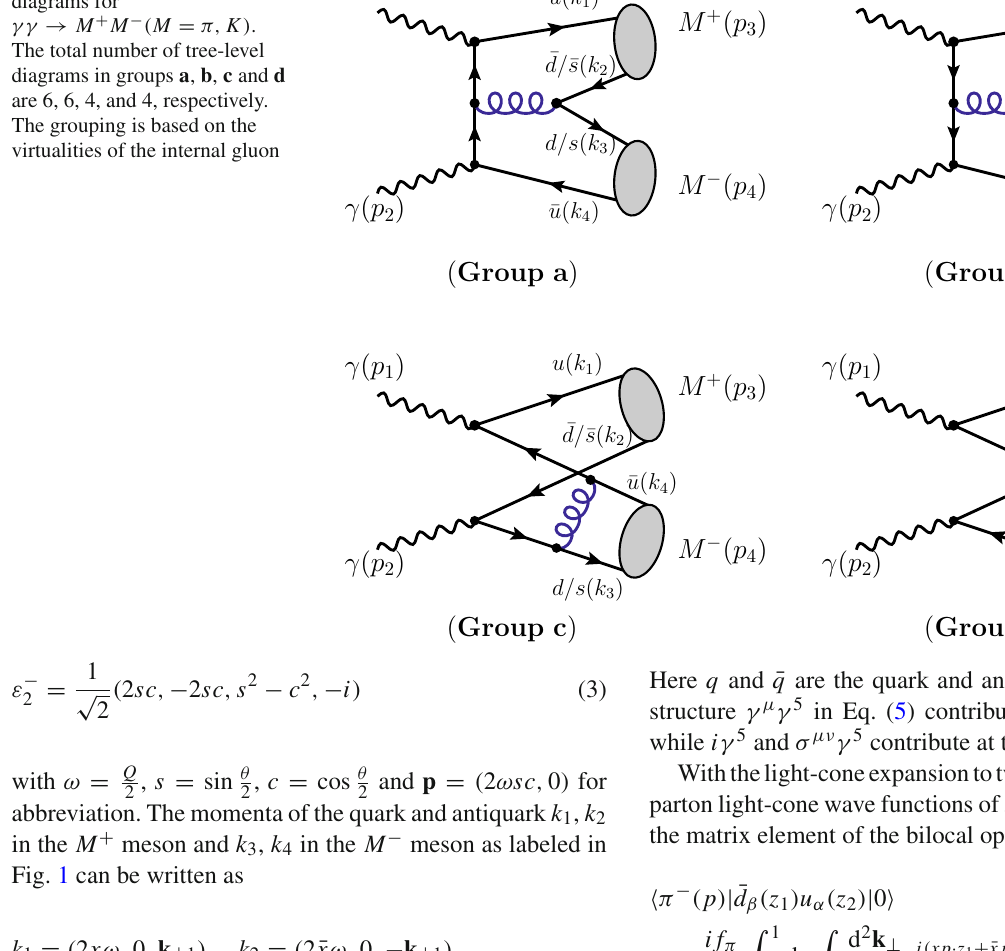
Fig. 1 Four basic Feynman diagrams for γγ → M + M − ( M = π, K )